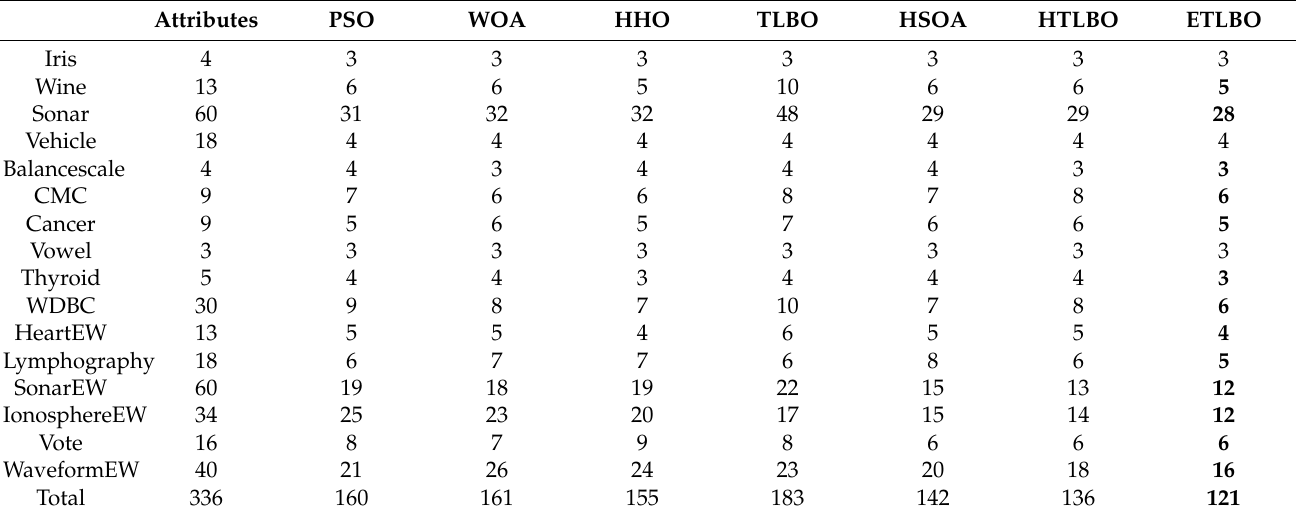
Table 4. The average number of selected attributes.